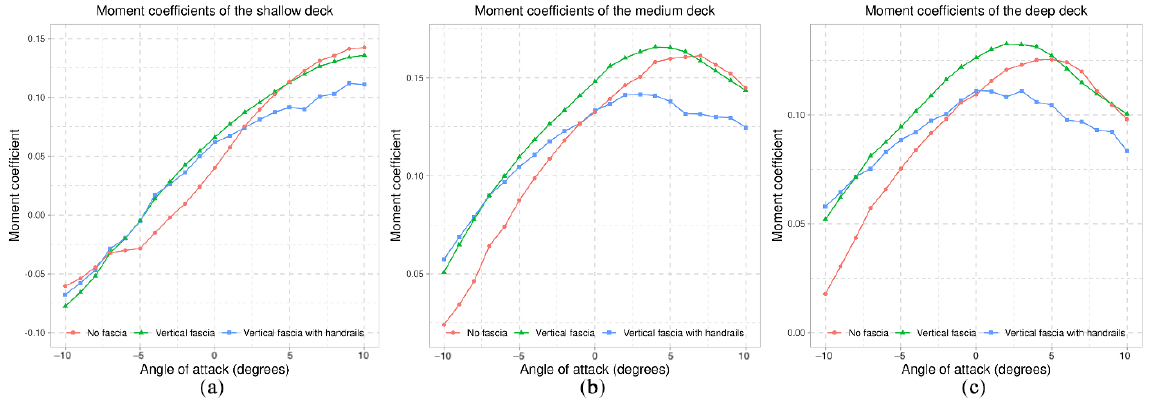
Figure 30. Change in moment coefficients with the inclusion of vertical fascia beams and handrails for the ( a ) shallow deck, ( b ) medium deck, and ( c ) deep deck.